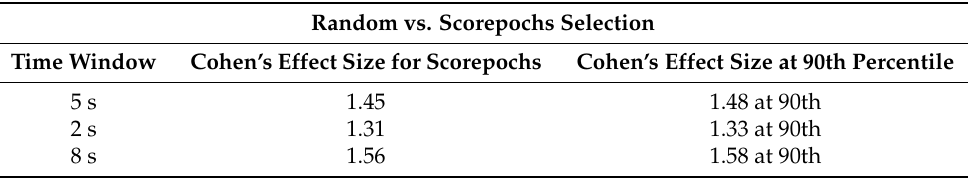
Table 1. The statistics for all comparisons between random and Scorepochs selections. Random vs. Scorepochs Selection